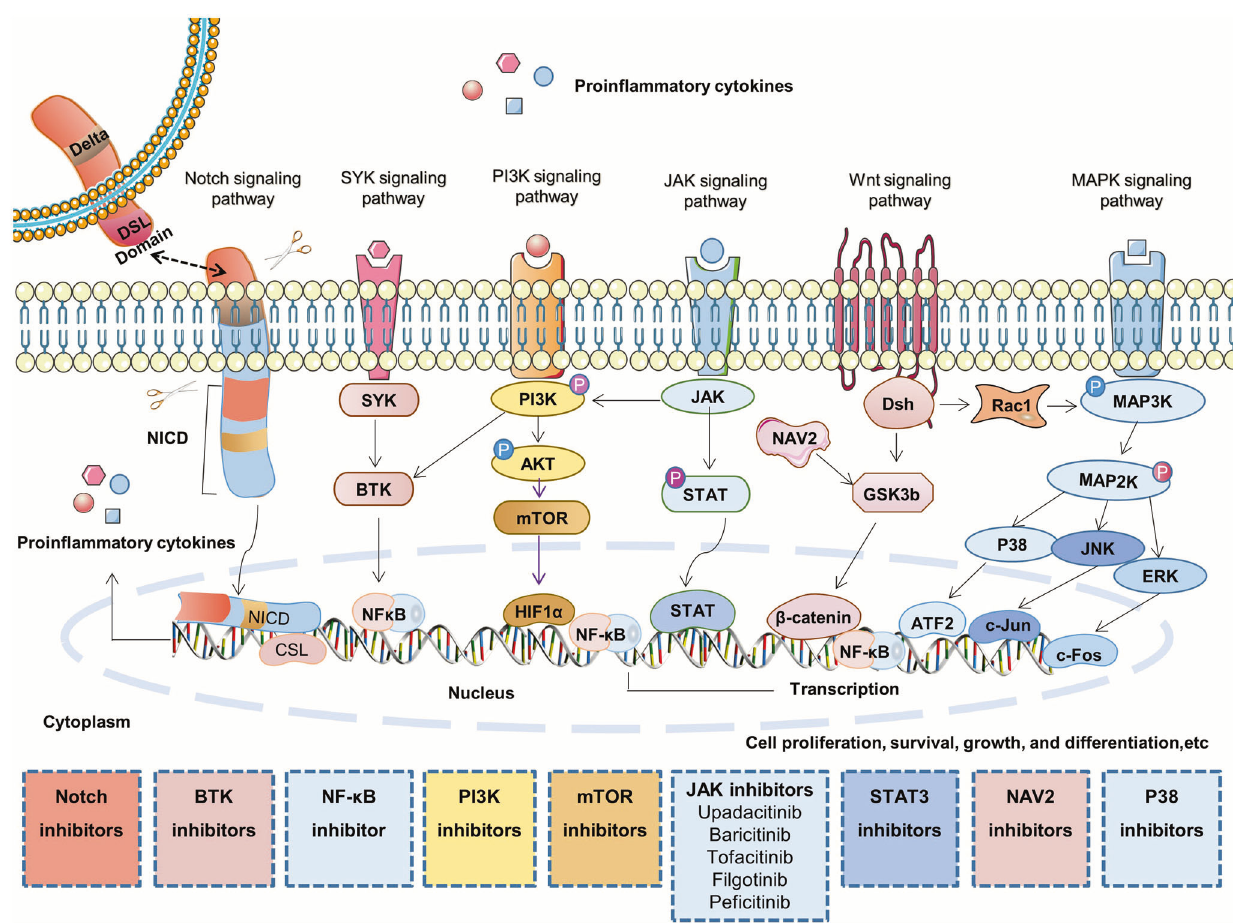
Fig. 5 Main signaling pathways and their inhibitors related to RA. The JAK signaling pathway, Notch signaling pathway, MAPK signaling pathway, Wnt signaling pathway, PI3K signaling pathway, and SYK signaling pathway are the main signaling pathways involved in the process of RA. Related signalings are often the potential targets for drug